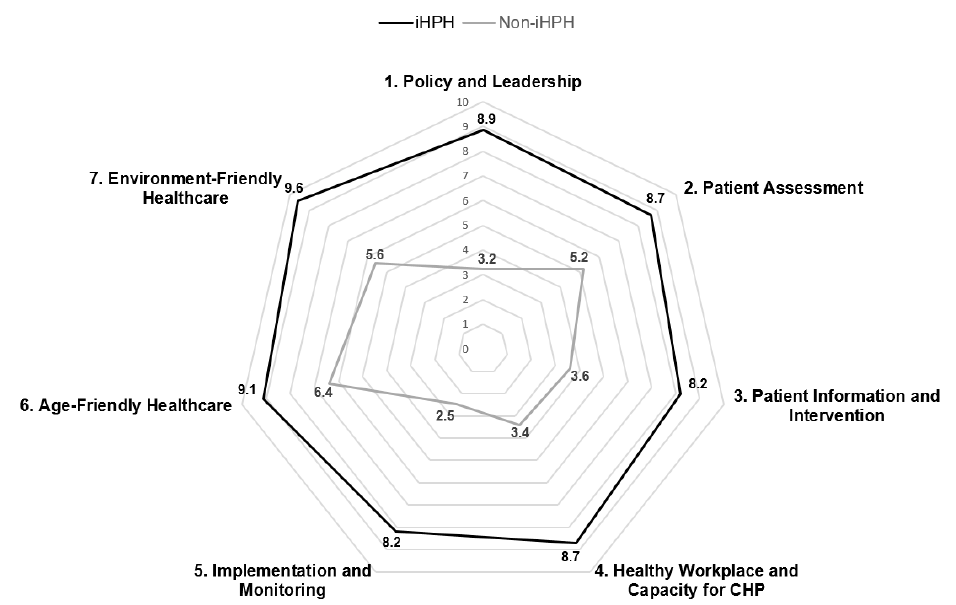
Figure 1. Radial plot graph of the standard compliance between iHPHs and non-iHPHs.